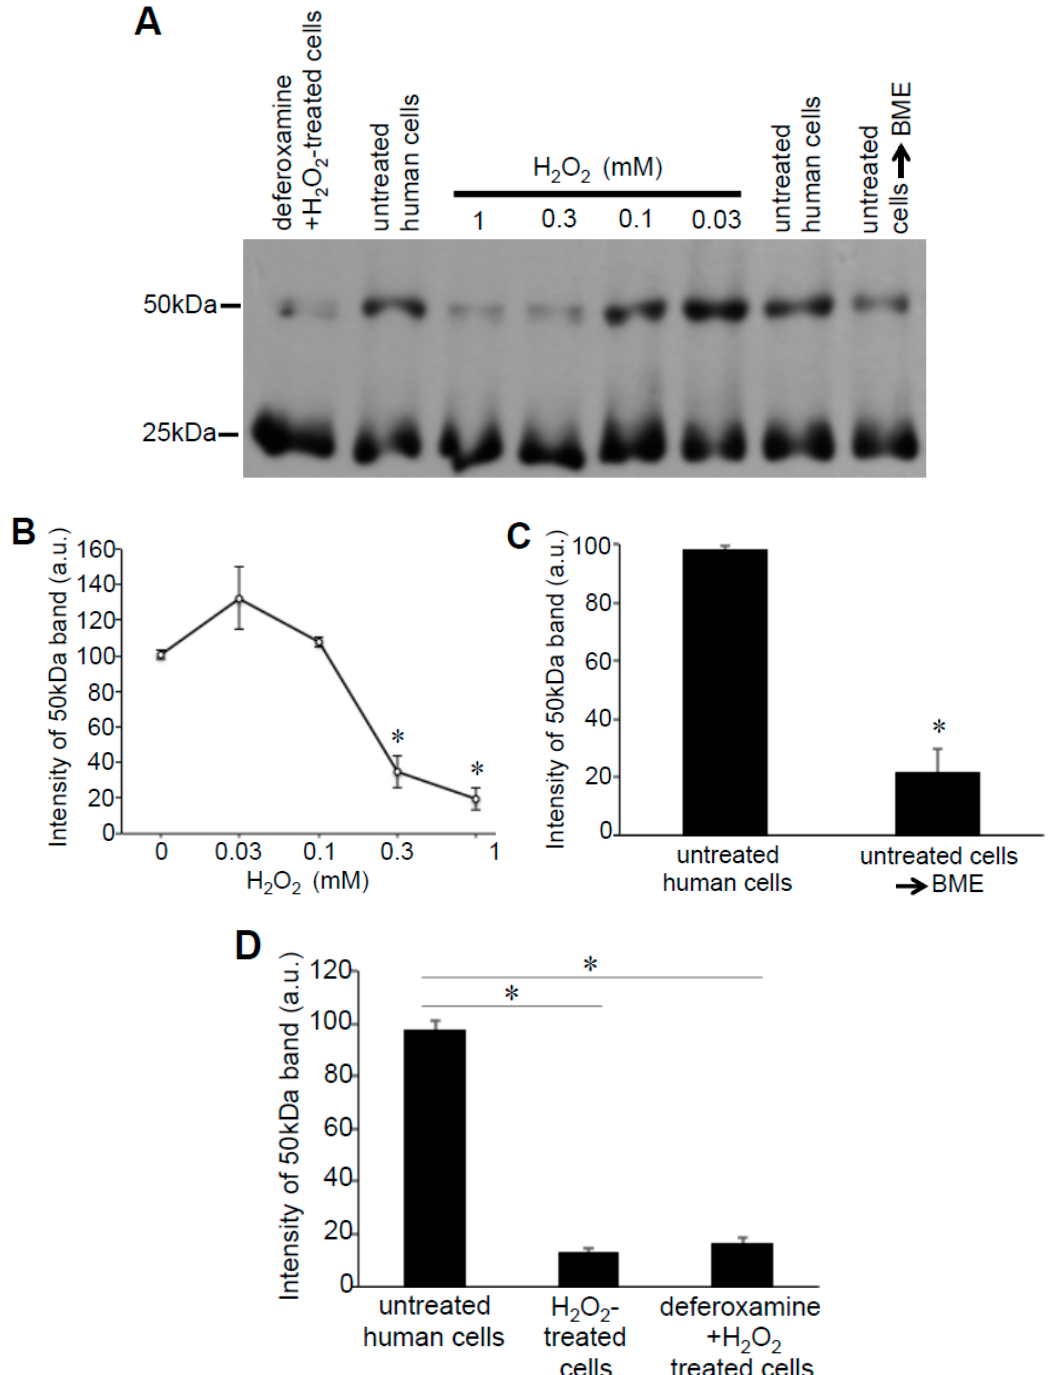
Figure 6. Effects of H 2 O 2 on Prx6 multimers in human cells. ( A ) Human pulmonary artery smooth muscle cells were pre-treated with or without 50 μ M deferoxamine for 30 min and then treated with or without H 2 O 2 for 15 min. Cell lysates were prepared and subjected to SDS-PAGE with or without 5% ( v/v ) BME in Laemmli buffer, and immunoblotted with the Prx6 antibody. No Protein-SHifters were added in these experiments. ( B – D ) Graphs represent the means ± SEM of the intensity of the 50-kDa band ( n = 3–6). The symbol * represents the value significantly different from the untreated control value at p < 0.05.